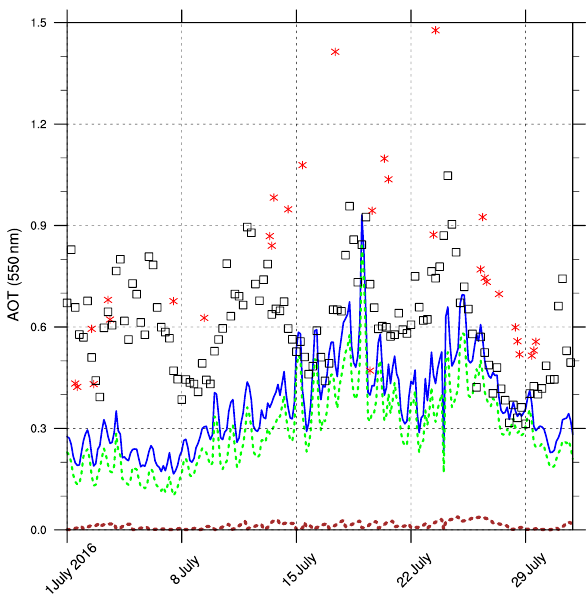
Figure 10. Comparison of 550nm AOD between NGACv2, ICAP- MME and AERONET location at Gabon for the month of July 2016. Blue line represents total AOD, green line is OC, and brown line represents BC AOD, all from NGACv2. Red asterisk symbol is for AERONET observations at that location, and black squares are ICAP-MME 6-hourly forecast. AERONET station location is marked in Fig.